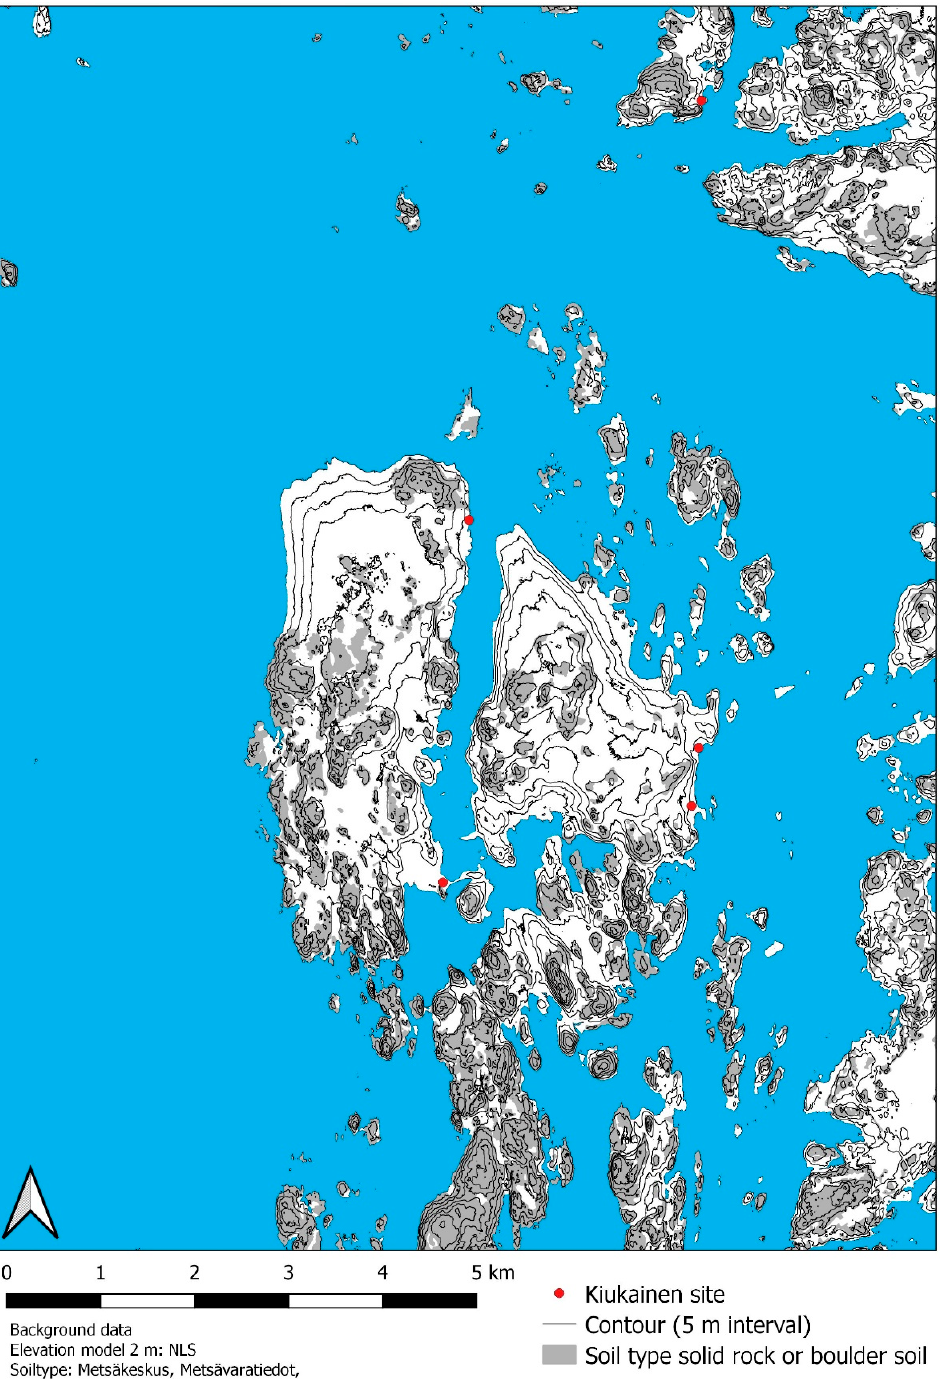
Figure 6. The locations of Kiukainen sites in the Kemiönsaari area and sea are visualized at 19 MASL. Areas with the soil type solid rock or boulder soil are visualized as grey.